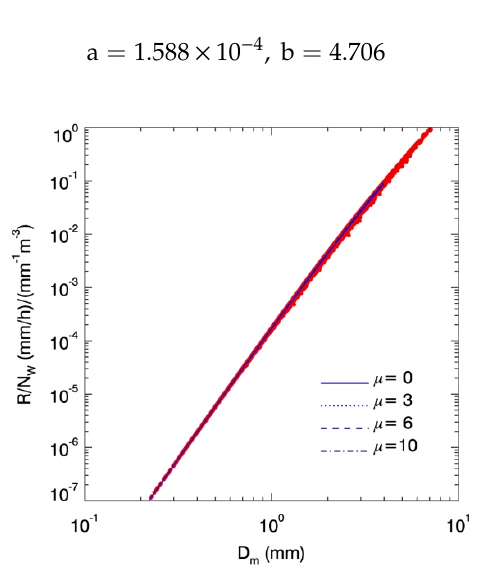
Figure 3. The ratios of R to N w in terms of D m , derived from the gamma DSD models with μ values varying from 0 to 10 (blue curves) and from the DSD measurement data (red dots).